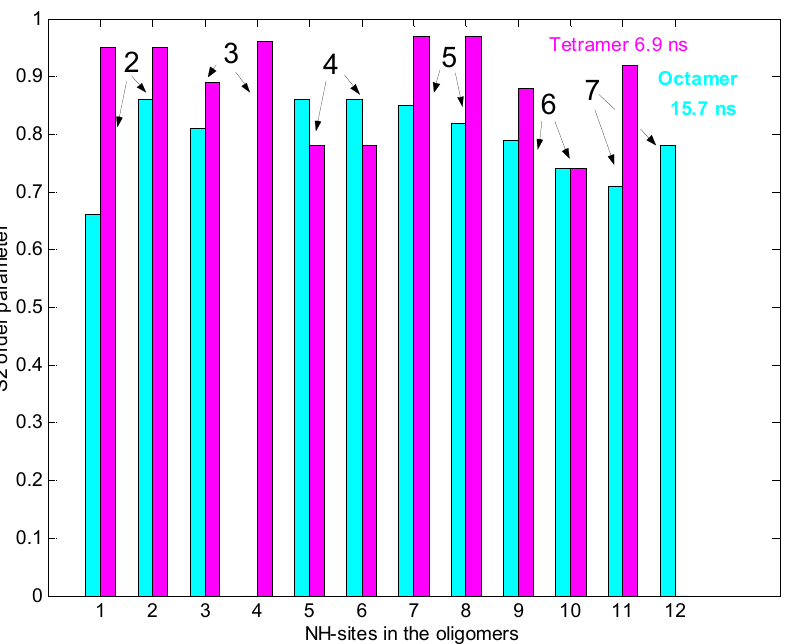
Figure 2. 15 NH S 2 order parameters from 15 N relaxation for tetra and octameric, N -Ac- D -Ala- D -Ala ligand-filled eremomycin (278 K). In the bar plot the tetramer is pink, and the octamer is cyan coloured. Numbers on the top of bars mean amino acid residues in the heptapeptide sequence.